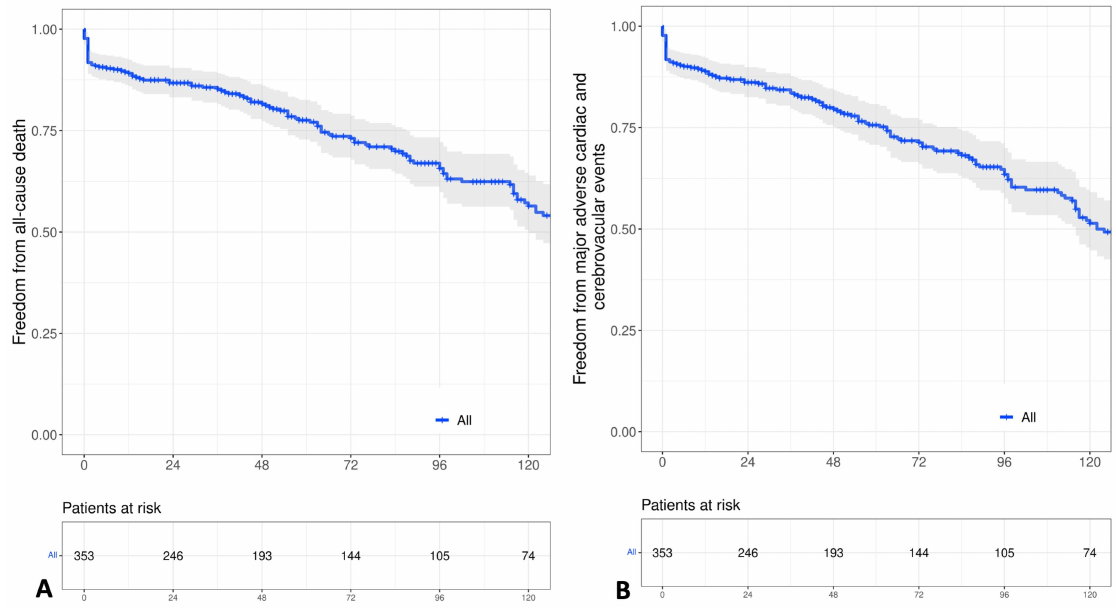
Figure 3. Kaplan-Meier curves showing long-term results regarding: ( A ) Overall estimated survival. ( B ) Overall freedom from